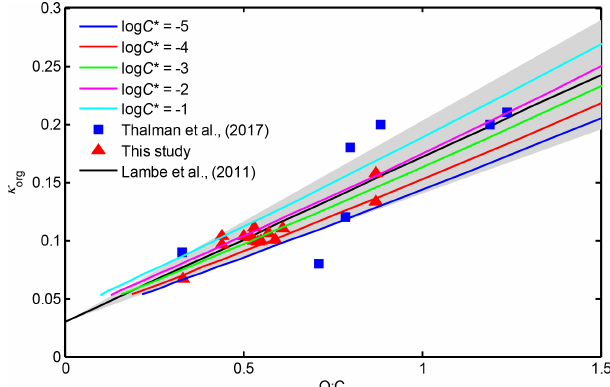
as a function of n C and log 10 C ∗ :